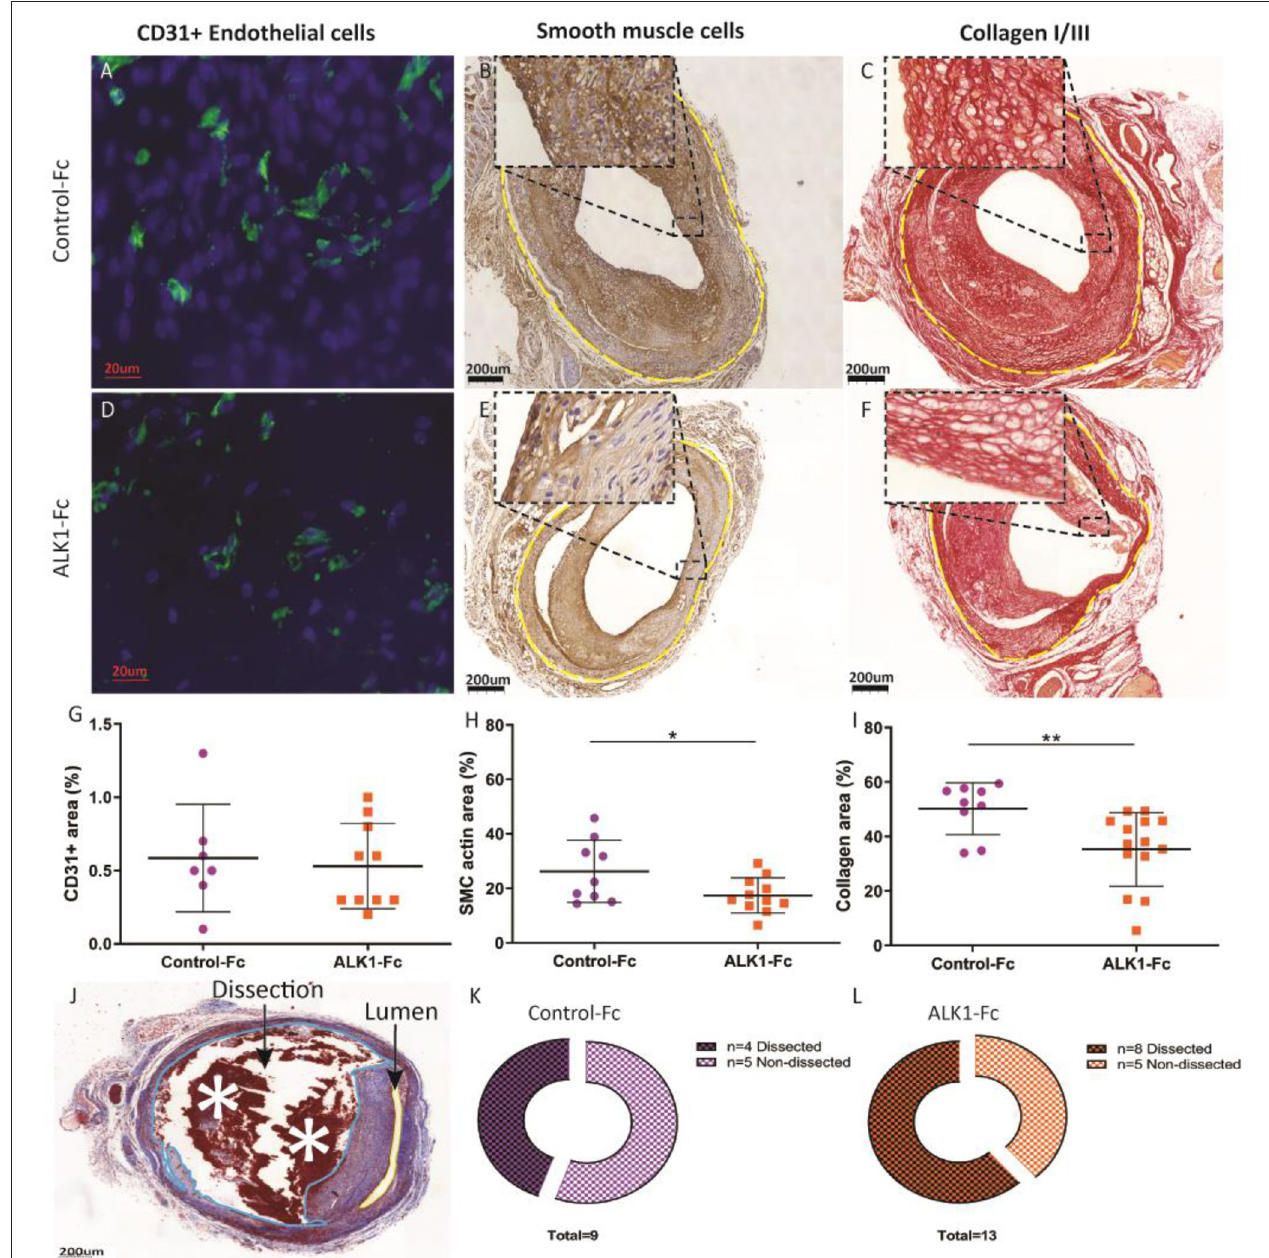
FIGURE 3 | Compositional analysis of ALK1-Fc or control-Fc treated mice. ALK1-Fc treated mice ( n = 11) were compared to control-Fc treated mice ( n = 8). Representative examples of CD31 staining (A) , vascular smooth muscle cells (B) , and collagen (C) from a control-Fc treated mouse and examples of CD31 staining (D) , vascular smooth muscle cells (E) , and collagen (F) from an ALK1-Fc treated mouse. The vein graft is highlighted by the yellow dotted line. The relative presence of the CD31 staining, vascular smooth muscle cells, and collagen was identified in the vessel wall via calculation of a percentage area (G–I) . Destabilizing plaque dissections characterized by blood-filled gaps within the intimal hyperplasia reaching from the lumen to the adventitia (J) , dissections (dissection blue, lumen yellow) in control-Fc treated mice (K) , and ALK1-Fc treated mice (L) . Statistical evaluation was performed with the unpaired parametric T -test * p < 0.05, ** p < 0.01.